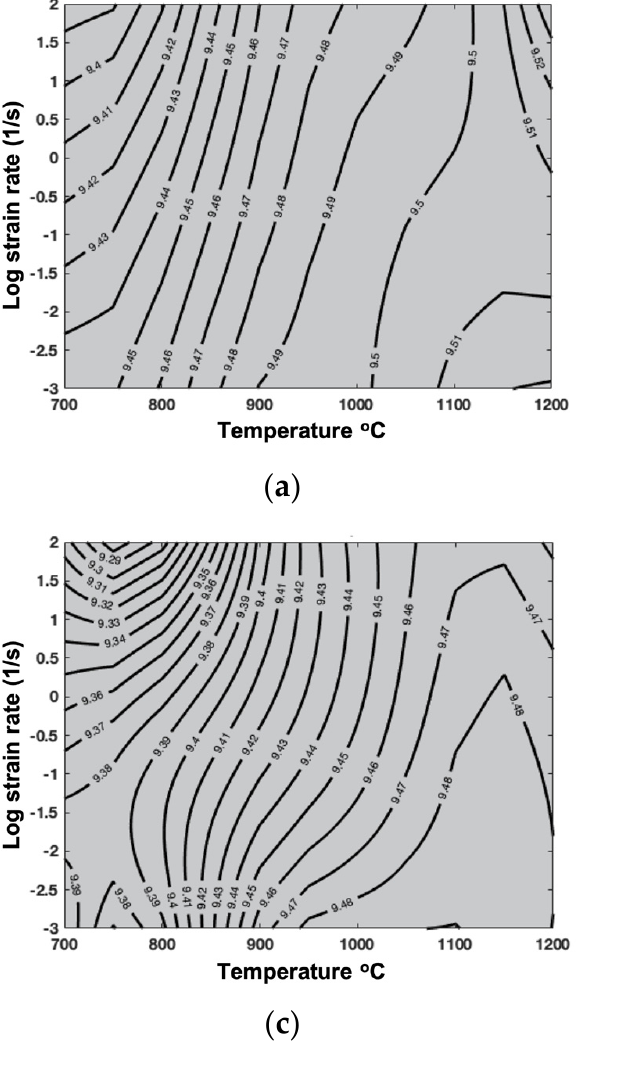
Figure 8. Process maps of the simulation results at a global true strain value of 0.2 with ( a ) 0% zirconia, ( b ) 5% zirconia, ( c ) 10% zirconia, and ( d ) 20% zirconia.